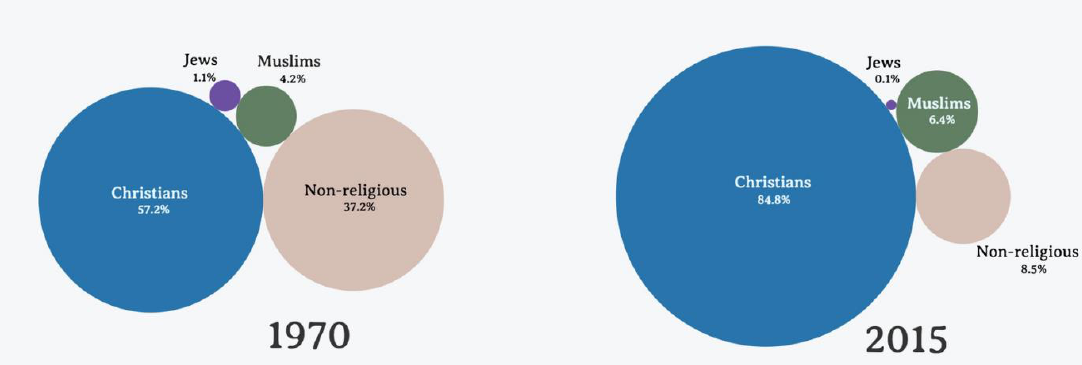
Figure 1. Religious diversity in Southern, Western and Northern Europe, 1970 and 2015.